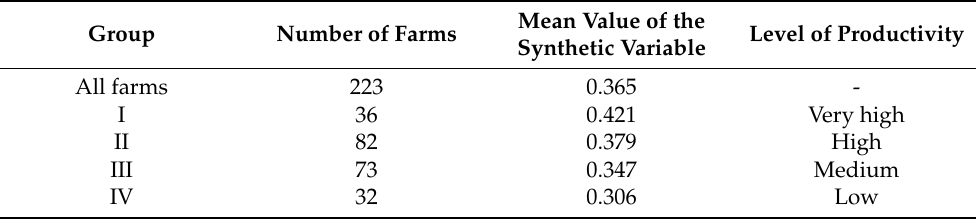
Table 6. Characteristics of farm classes in terms of land productivity. Mean Value of the Group Number of Farms Level of Productivity Synthetic Variable All farms 223